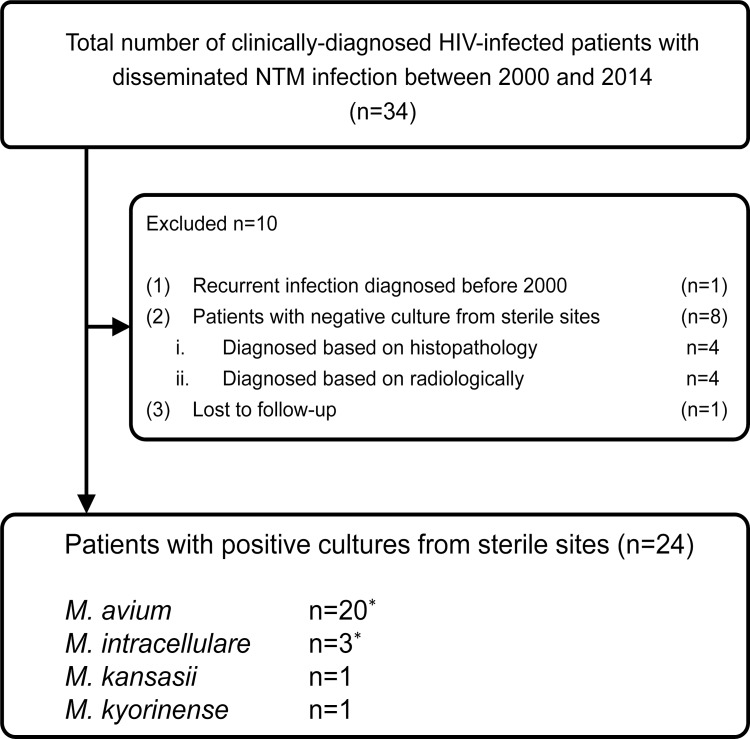
Patient enrollment.*Both M. avium and M. intracellulare were detected in blood culture of one patient.